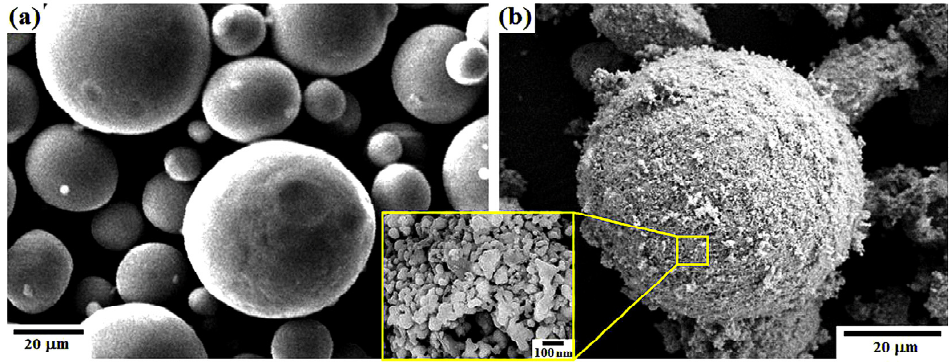
(c) Figure 1. Surface SEM image of ( a ) NiCoCrAlY powders; ( b ) agglomerated nano-YSZ powders [8]. (Copyright 2016